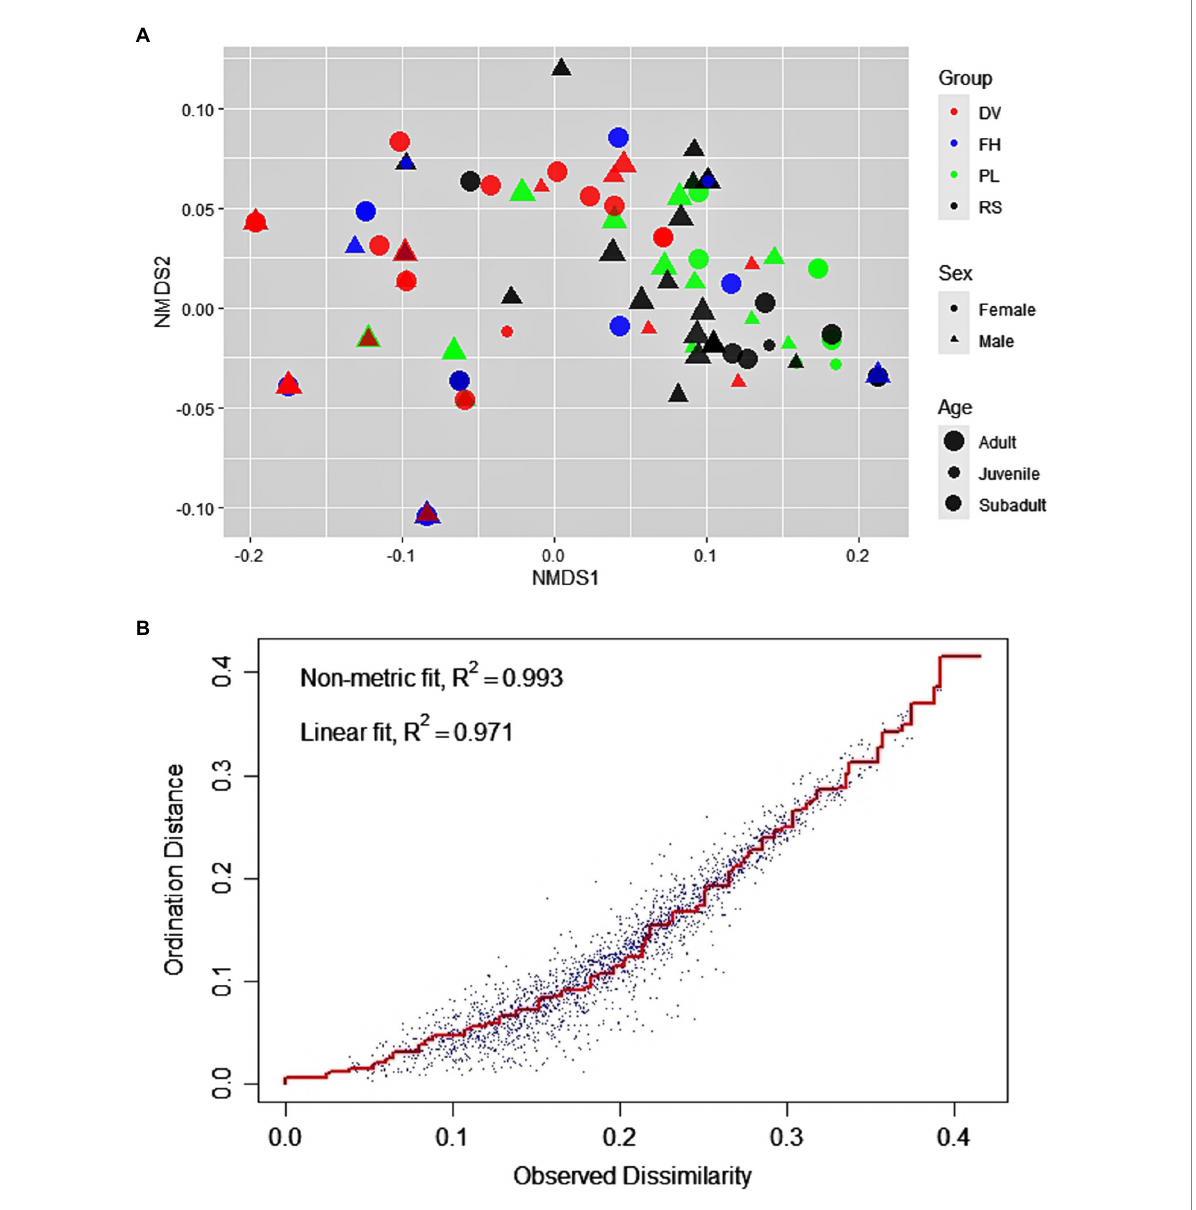
FIGURE 1 Distribution of the 123 events of bottle-directed manipulative techniques, displayed by the study bonnet macaque population during Task I, as analyzed by two-dimensional Non-metric Multi-Dimensional Scaling (NMDS), using the Jaccard similarity measure. ( A). The groups are indicated by different colors: DV – red, FH – blue, PL – green, RS – black; sexes by different shapes: female – circle, male – triangle; and age classes by the size of the points: adult > subadult > juvenile. ( B). Stress-plot of the NMDS. Stress = 0.08, non-metric R 2 =